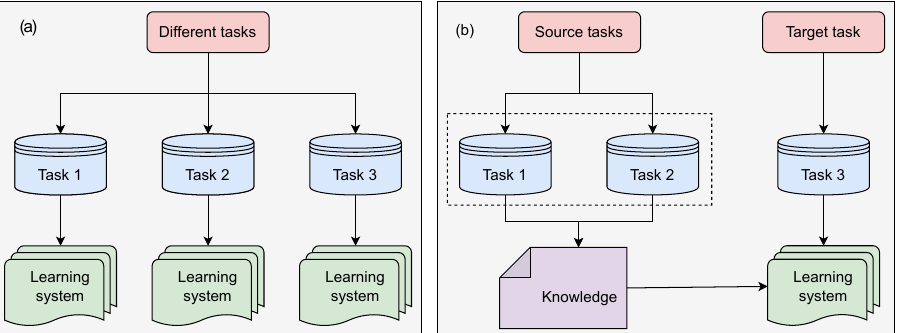
Figure 2. Typical ( a ) Machine Learning and ( b ) Transfer Learning